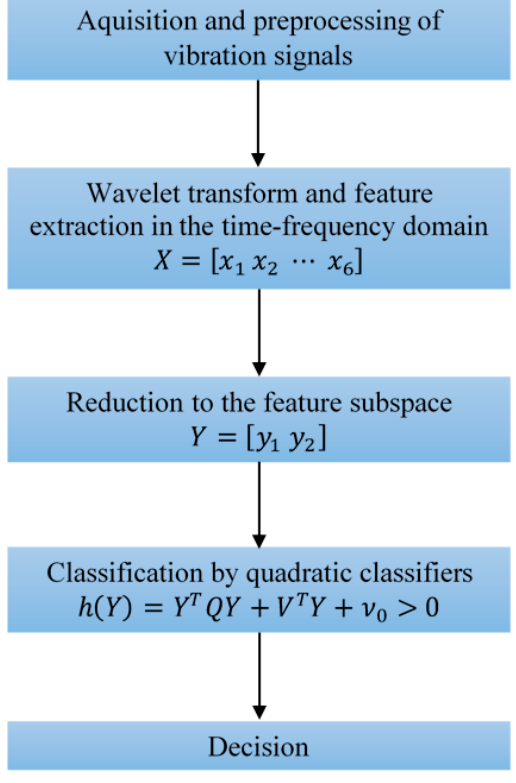
Figure 5. Flowchart of the new technique for early FDD .